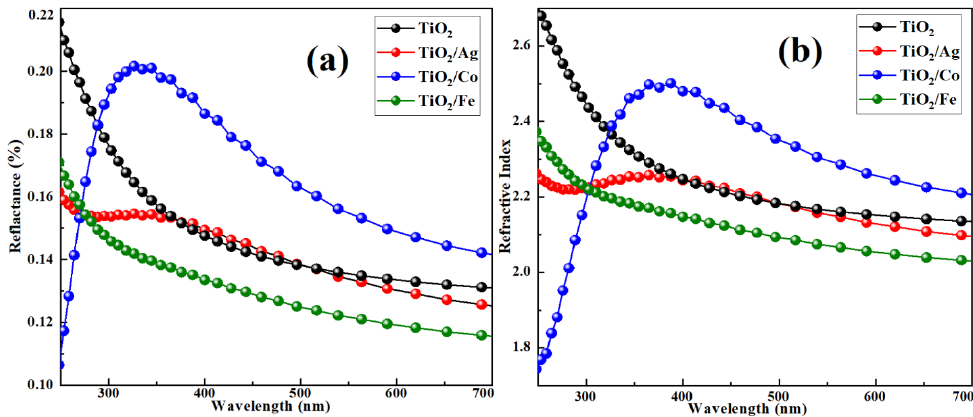
Figure 8. ( a ) Reflectance and ( b ) refractive index for pure and doped TiO 2 anatase.